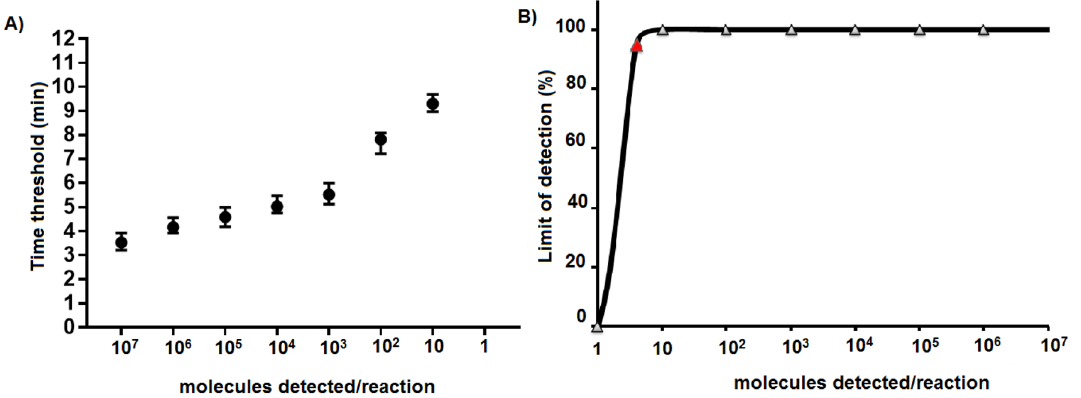
Figure 1. Analytical sensitivity of the RABV-RPA assay. A semi-log regression analysis ( A ) was performed by plotting the RABV-RPA threshold time values against the number of RNA molecules detected in eight replicates (8/8). The RABV-RPA assay produced positive results between 3 and 10 min. Dilutions 10 7 to 10 RNA molecules were detected 8 out of 8 runs and 1 molecule was not identified by the RT-RPA assay. The dots represent the mean values and the error bars represent the standard deviation. The probit regression analysis ( B ) was performed using data of eight RABV-RPA assay runs. The limit of detection at 95% probability (4 RNA molecules/reaction) is depicted by the red triangle. The graphs were plotted using PRISM (Graphpad Software Inc., San Diego,